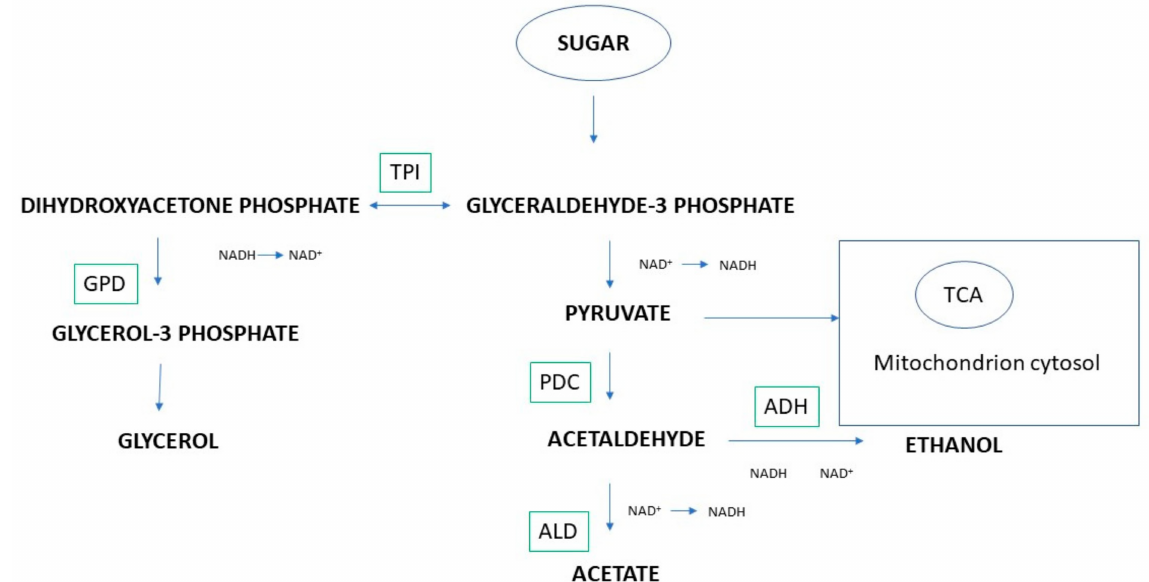
Figure 1. Overview of sugar catabolism in yeast cells during alcoholic fermentation. GPD: glycerol-3-phosphate dehydroge- nase; PDC: pyruvate decarboxylase; ADH: alcohol dehydrogenase; ALD: aldehyde dehydrogenase; TPI: triosephosphate isomerase. Pyruvate originating is partially shuttled to the mitochondrion and incorporated into the tricarboxylic acid (TCA)